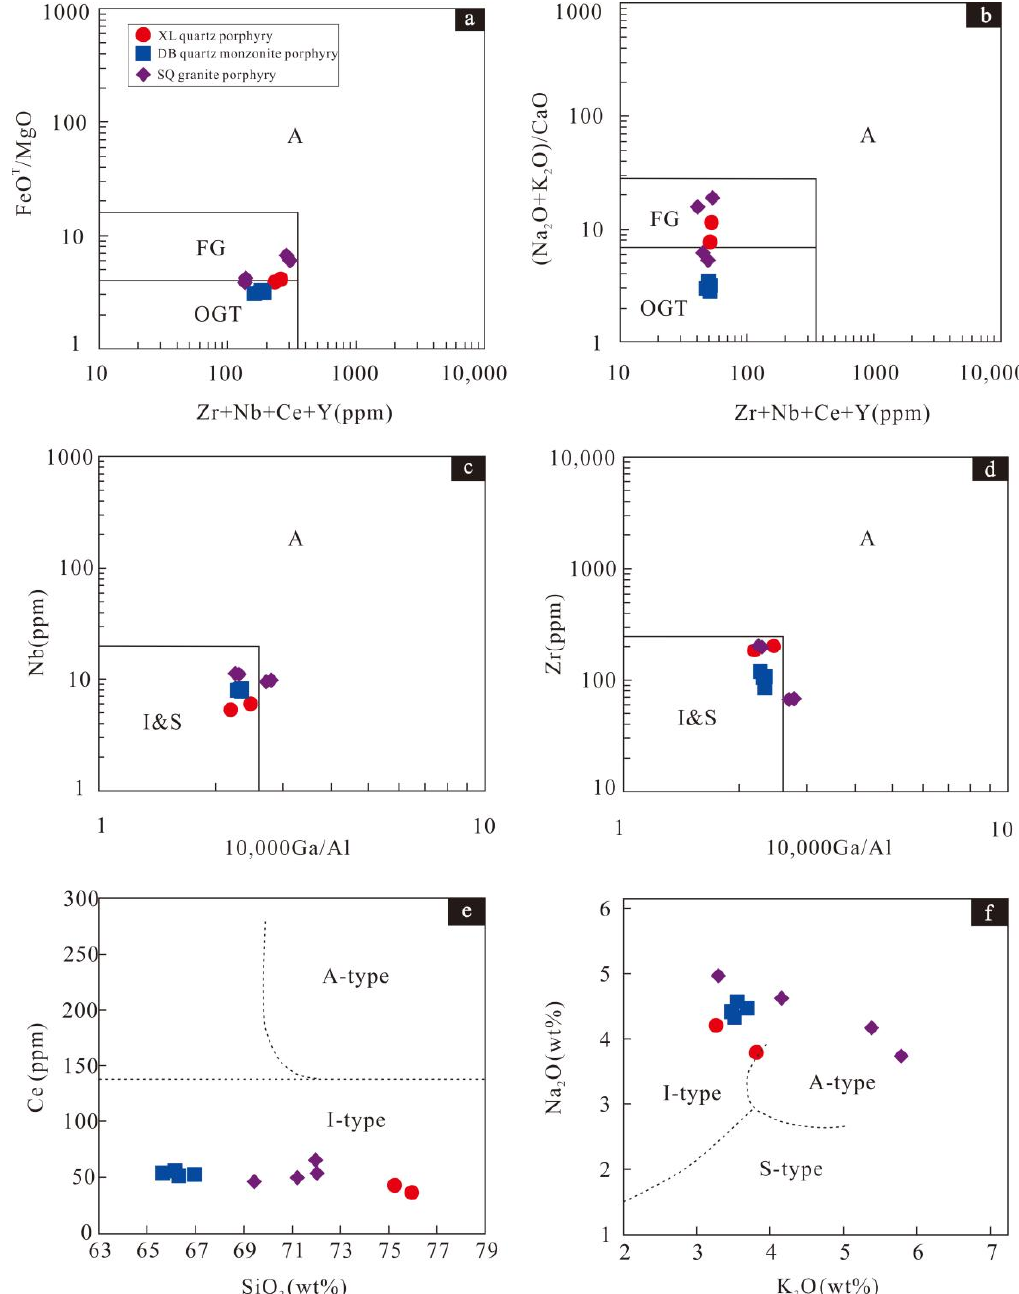
Figure 10. Diagram of discriminate genesis of intrusive rocks in the study area: ( a ) SiO 2 versus FeO T /(FeO T + MgO) diagram (Whalen et al. [128]); ( b ) (Zr + Y + Nb + Ce) versus (Na 2 O + K 2 O)/CaO diagram (Whalen et al. [128]); ( c ) (10,000 × Ga/Al) versus Nb diagram (Whalen et al. [128]); ( d ) (10,000 × Ga/Al) versus Zr diagram (Whalen et al. [128]); ( e ) SiO 2 versus Ce diagram (Collins [126]); ( f ) K 2 O versus Na 2 O diagram (Collins [126]).